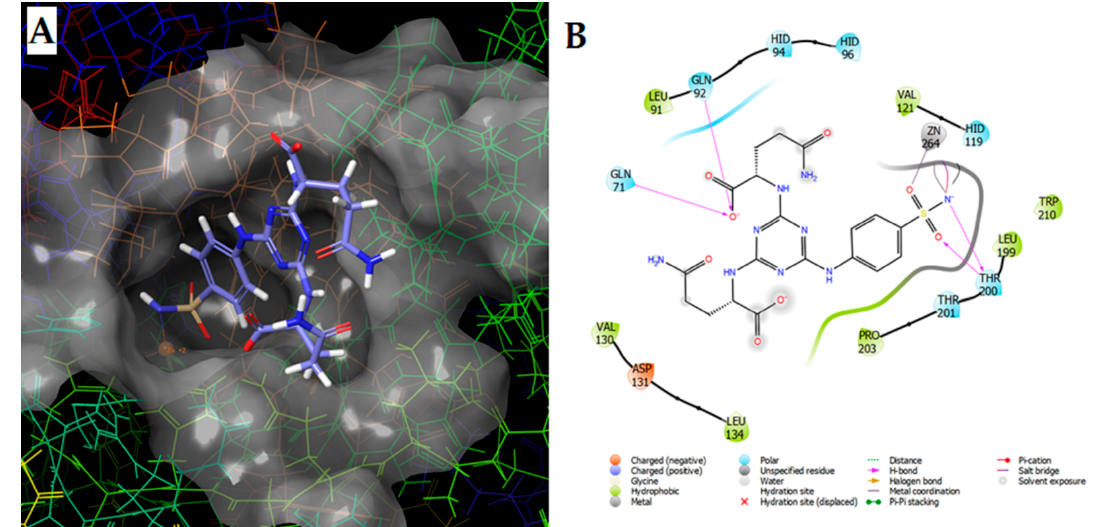
Figure 19. Position of sulfonamide-derived hCA IX inhibitor docked into the active site of hCA IX ( A ) and its intermolecular interaction diagram ( B ) [239].